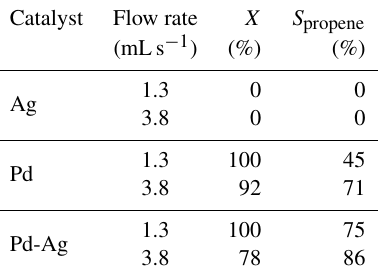
Table 1. Hydrogenation of propyne with parahydrogen over Ag / Al 2 O 3 , Pd / Al 2 O 3 , and Pd-Ag / Al 2 O 3 catalysts: propyne con- version ( X ) and selectivity to propene ( S propene ) at different gas mixture flow rates and reaction temperature of 200 ◦